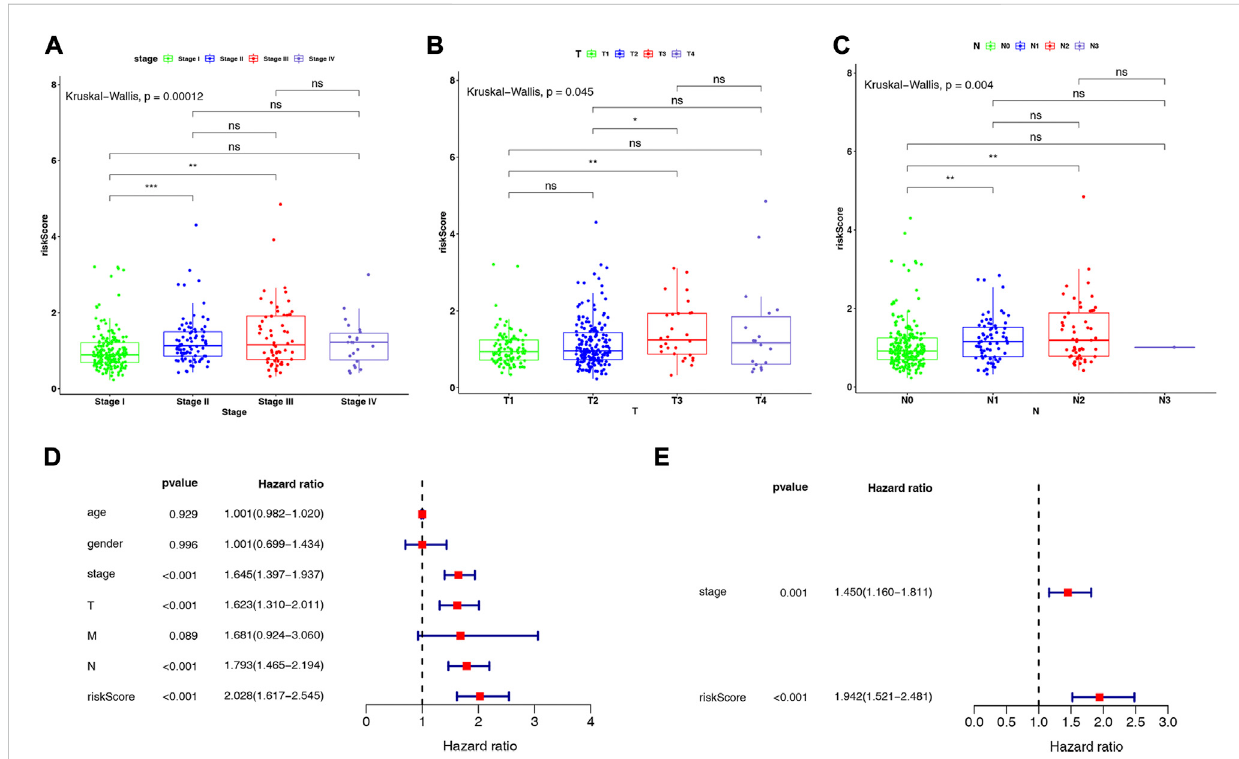
FIGURE 5 Differencesinriskscoresin (A) stagesubgroups, (B) T-stagesubgroups,and (C) N-stagesubgroups.Resultsof (D) univariateand (E) multivariateCox regression analyses on clinical characteristics of LUAD in the TCGA-LUAD